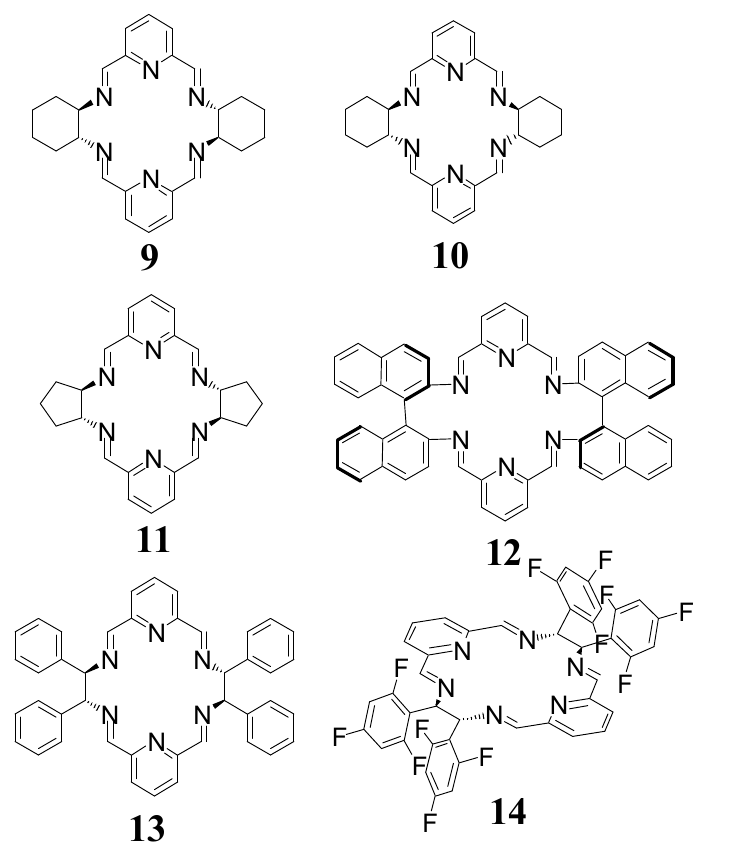
Figure 6. Imine [2 + 2] macrocycles derived from 2,6-diformylpyridine.